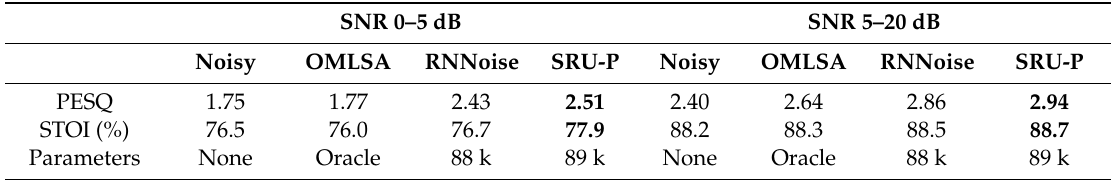
Table 1. The postfilter (single-channel) speech enhancement results obtained with optimally modified log-spectral amplitude (OMLSA), Recurrent neural network (RNN) noise and the proposed method, where noisy means the unprocessed original signal.